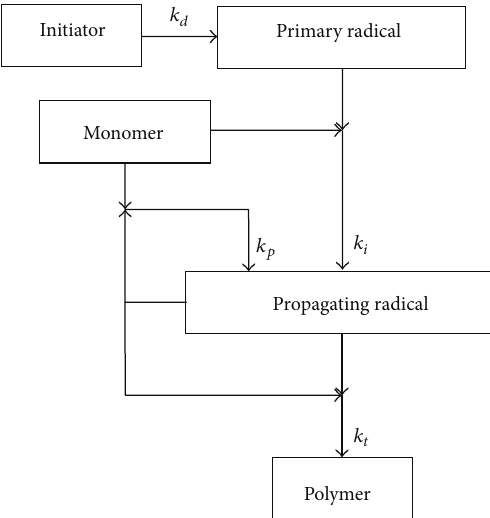
Figure 1: Reaction path of radical polymerization.